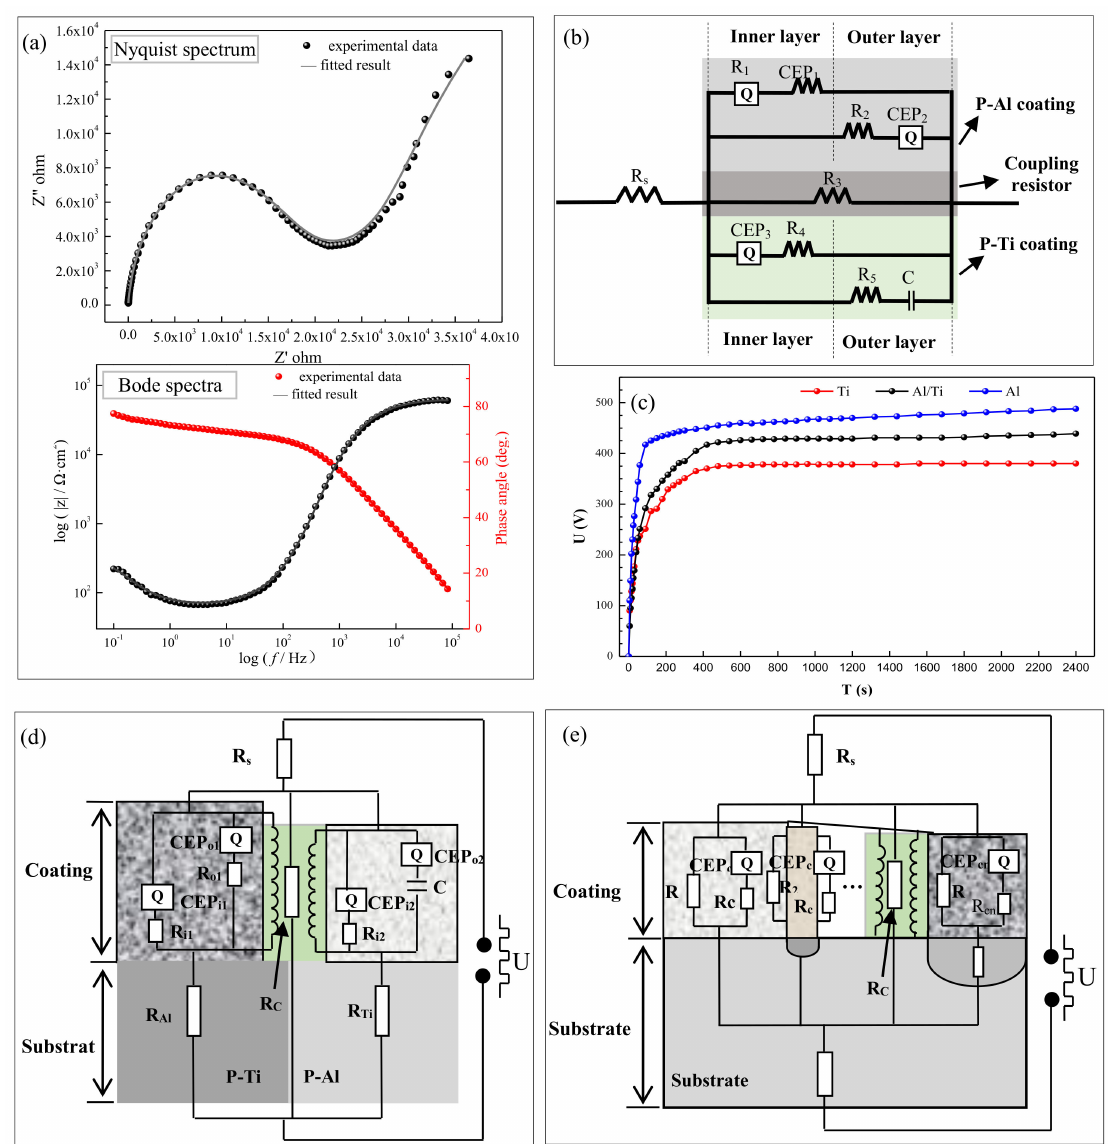
Figure 4. ( a ) Electrochemical impedance spectroscopy (EIS) spectra of the plasma electrolytic oxidation (PEO) coating at the welding joint; ( b ) equivalent circuit of the EIS spectra; ( c ) voltage-time curves at constant current mode of di ff erent samples; ( d ) schematic diagram of the equivalent circuit for the Al-Ti coating; ( e ) schematic diagram of the equivalent circuit for the general metal matrix composites